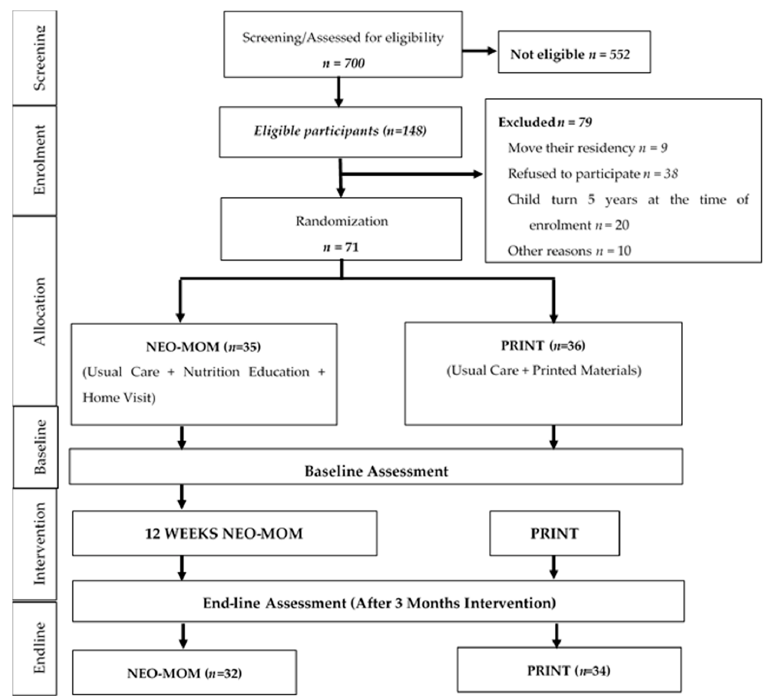
Figure 1. Adapted CONSORT diagram of the Nutrition Education for Overweight/Obese Mother with Stunted Children (NEO-MOM) study.